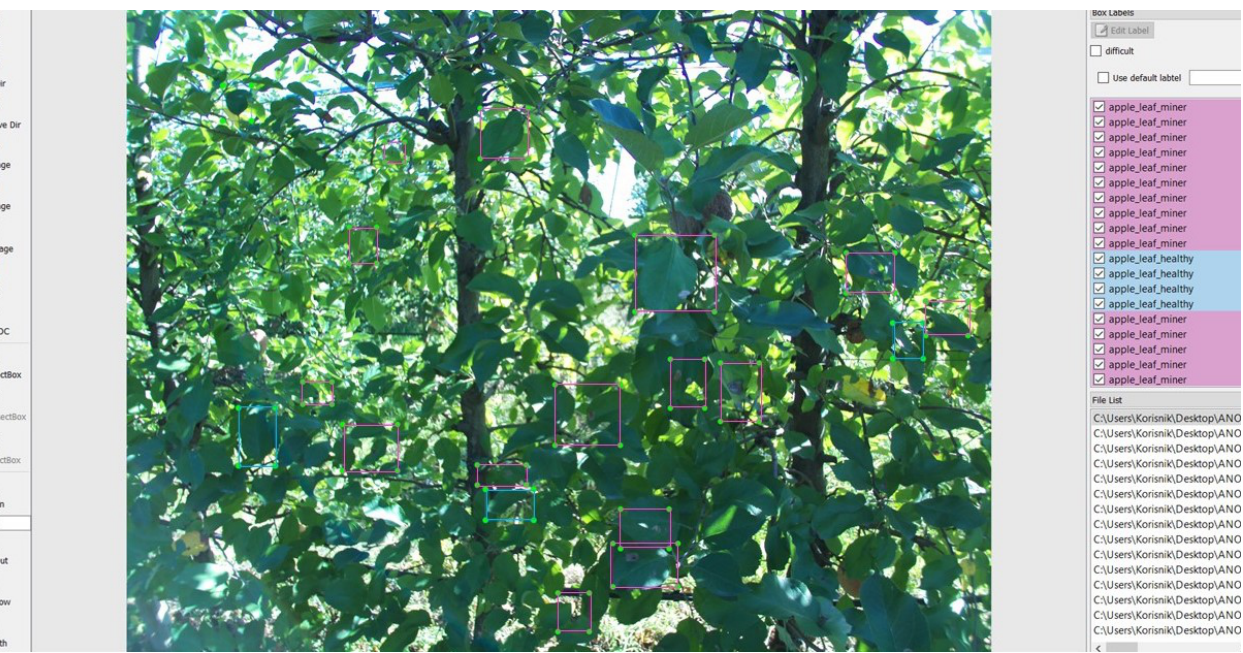
Figure 3. Annotated class MINES (damage caused by L. malifoliella ) — marked with pink bounding boxes, class OTHER (other objects, healthy leaves, etc.) marked with light blue bounding boxes in the LabelImg program from images of vegetation.